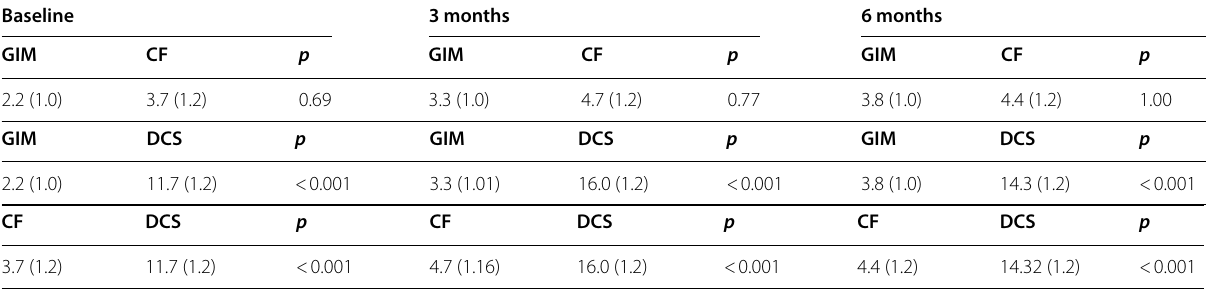
Data reported as model-adjusted means (SE). Comparisons reported using adjusted p